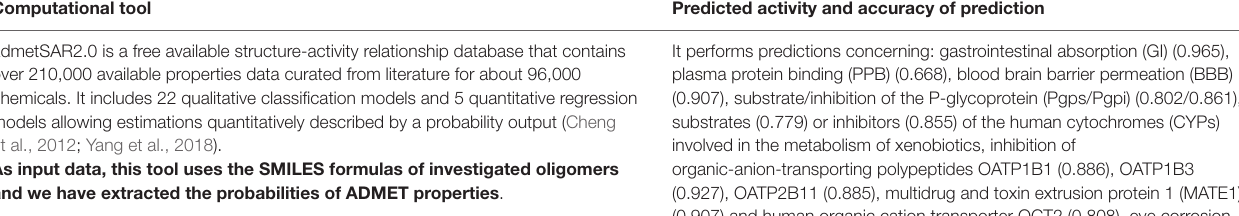
TABLE 2 | In silico tools considered for assessing the ADMET profiles of investigated